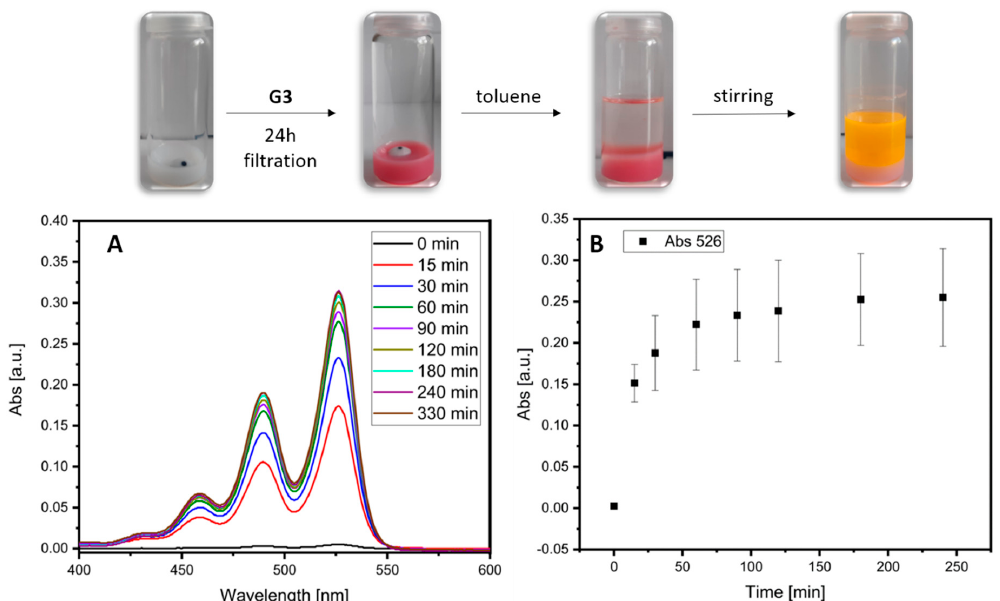
Figure 4. Time-dependent release of G3 from the loaded nanocarrier [TiO 2 -PAC 16 ]@guest G3 @shell 1 in a biphasic system (water/toluene). ( A ) Absorption spectra taken from diluted aliquots of the organic phase during measurement series 1. ( B ) Mean absorption at 526 nm plotted vs time.